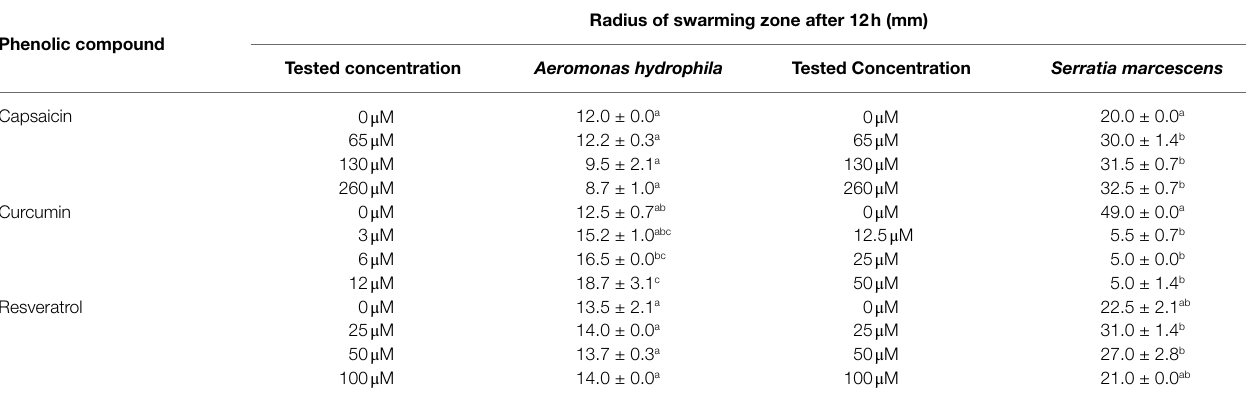
TABLE 2 | Effect of capsaicin, curcumin, and resveratrol on swarming motility of Aeromonas hydrophila IOC/FDA 110-36 and Serratia marcescens MG1. Radius of swarming zone after 12 h (mm) Phenolic compound Tested concentration Aeromonas hydrophila Tested Concentration Serratia marcescens